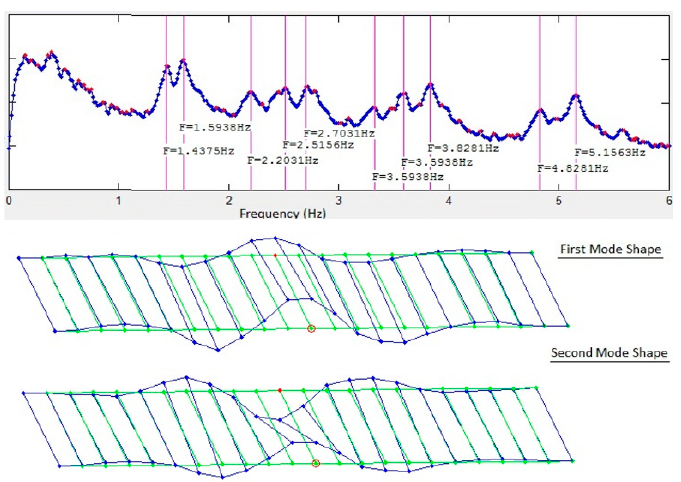
Figure 13. Final solution set obtained by selecting the second solutions for nodes #26, #30, and #43.